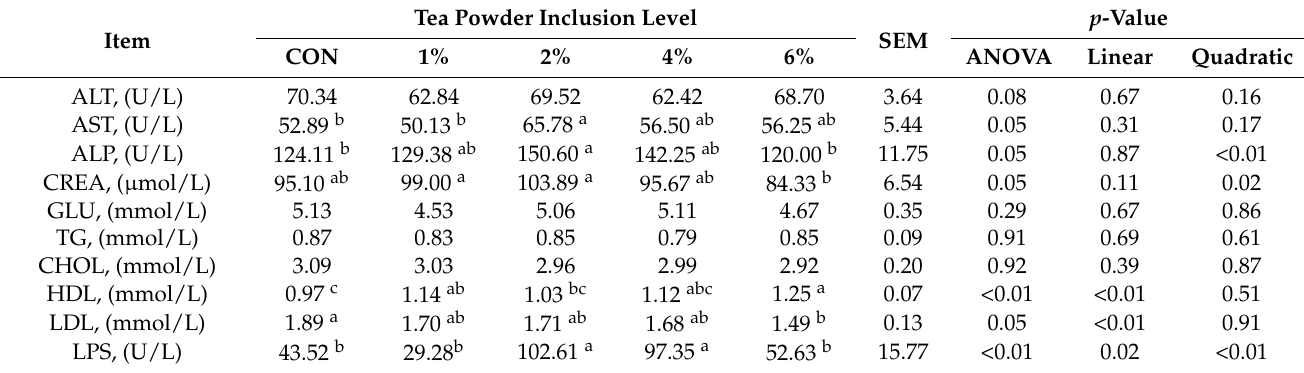
Table 9. Effects of dietary supplements with tea powder on serum biochemical indices of the pigs.